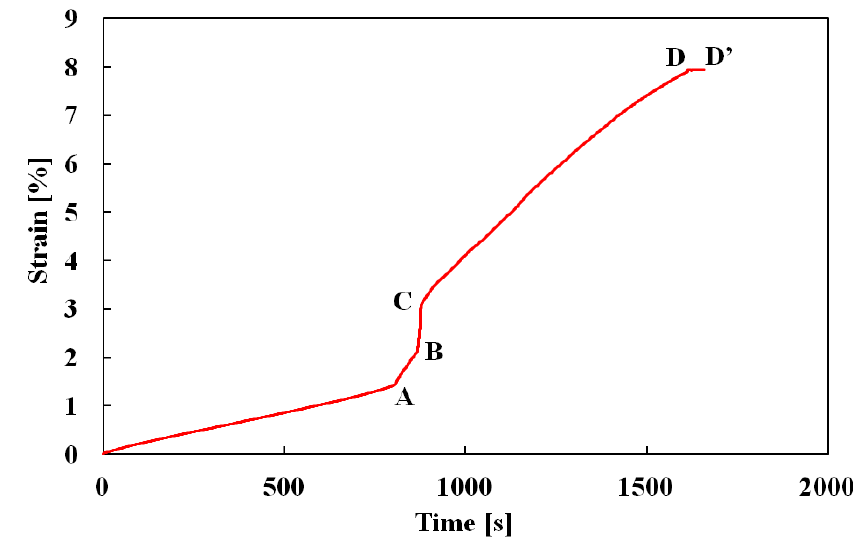
Figure 6. Variation in strain with passing of time in creep